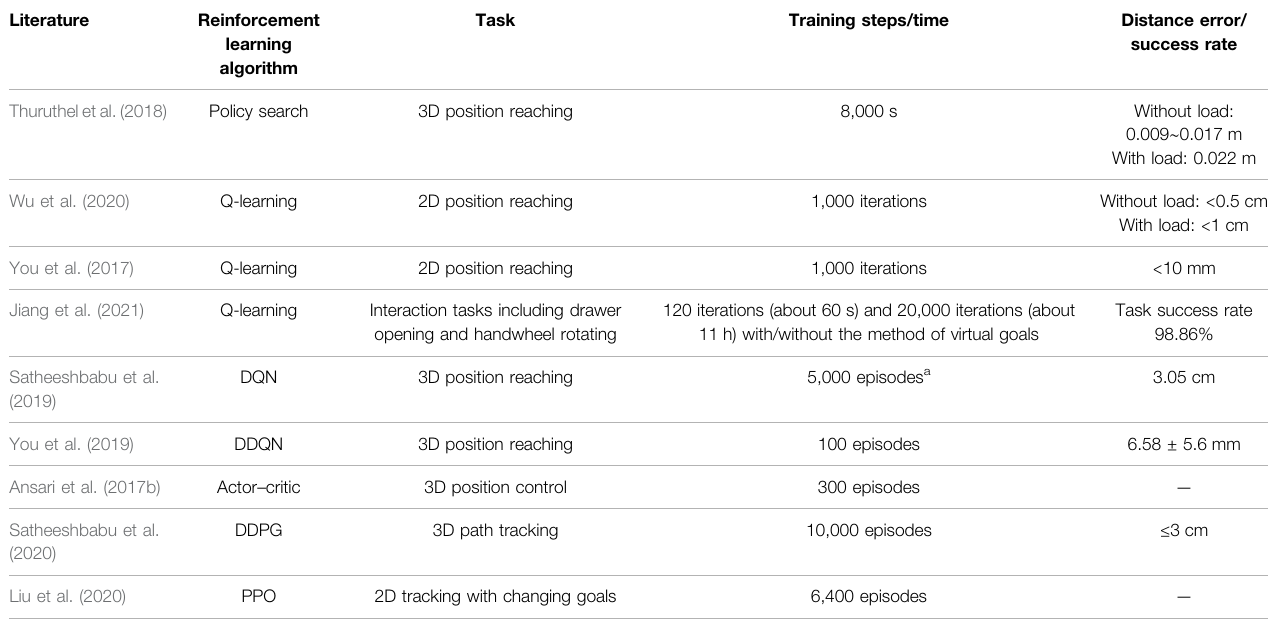
TABLE 2 | Sampling of reinforcement learning control for continuum robots, including the algorithm, task, and training duration. Intended to be exemplary, not comprehensive. Literature